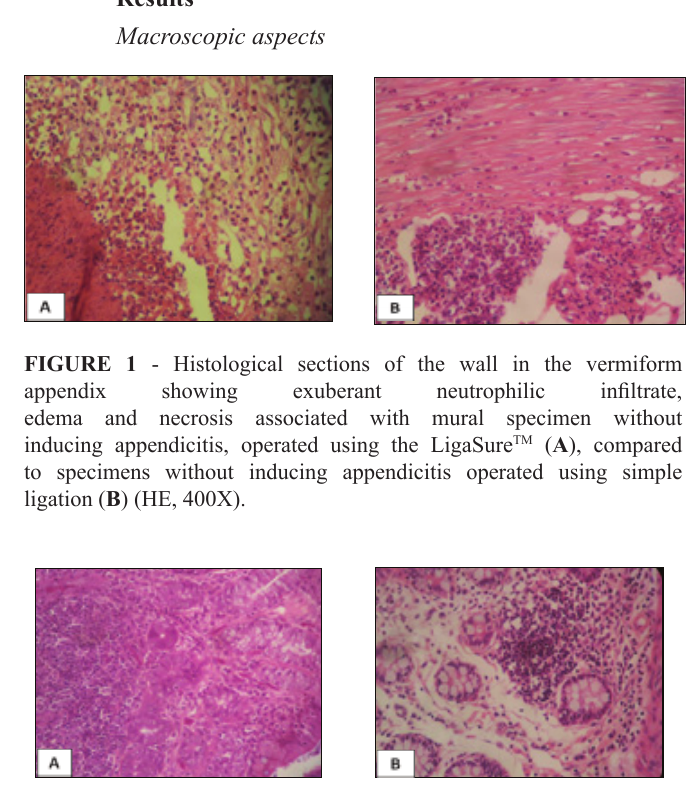
FIGURE 2 - Histological sections of the appendicular mucosa showing exuberant lymphocytic infiltrate including reactive follicular hyperplasia in the specimen with induction of appendicitis, treated with simple ligation ( A ), compared to mucosa with mild lymphocytic inflammatory infiltrate, sometimes with lymphoid arrangements in specimen with induction of appendicitis treated with LigaSure TM ( B ) (HE, 400X).